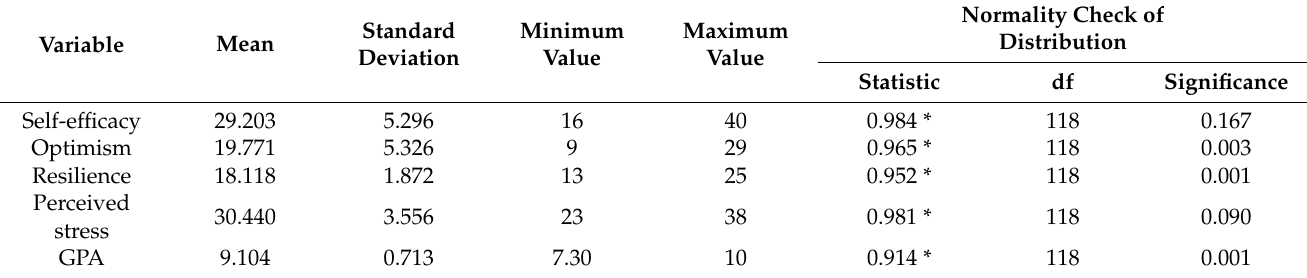
Table 1. Scores of the study